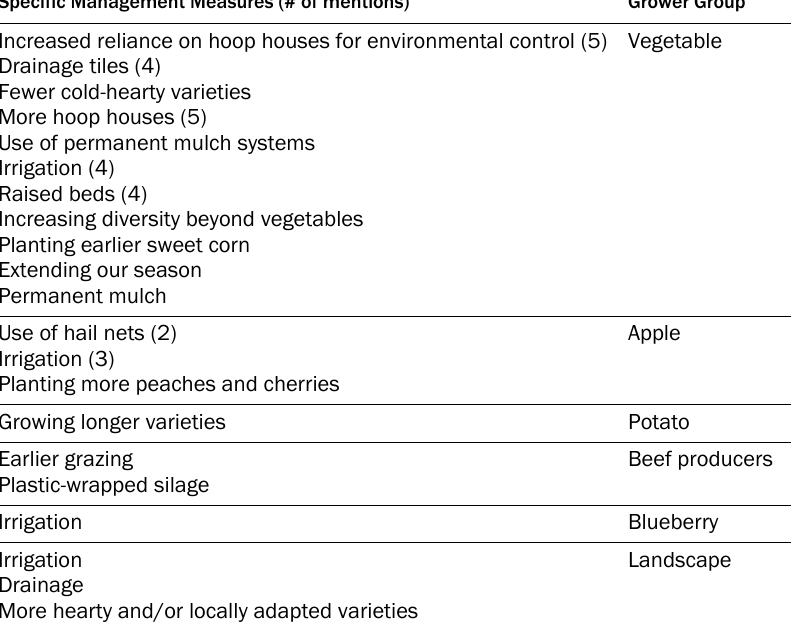
Table 5. Specific Management Measures Implemented Due to Fluctuating Weather Patterns or a Warming